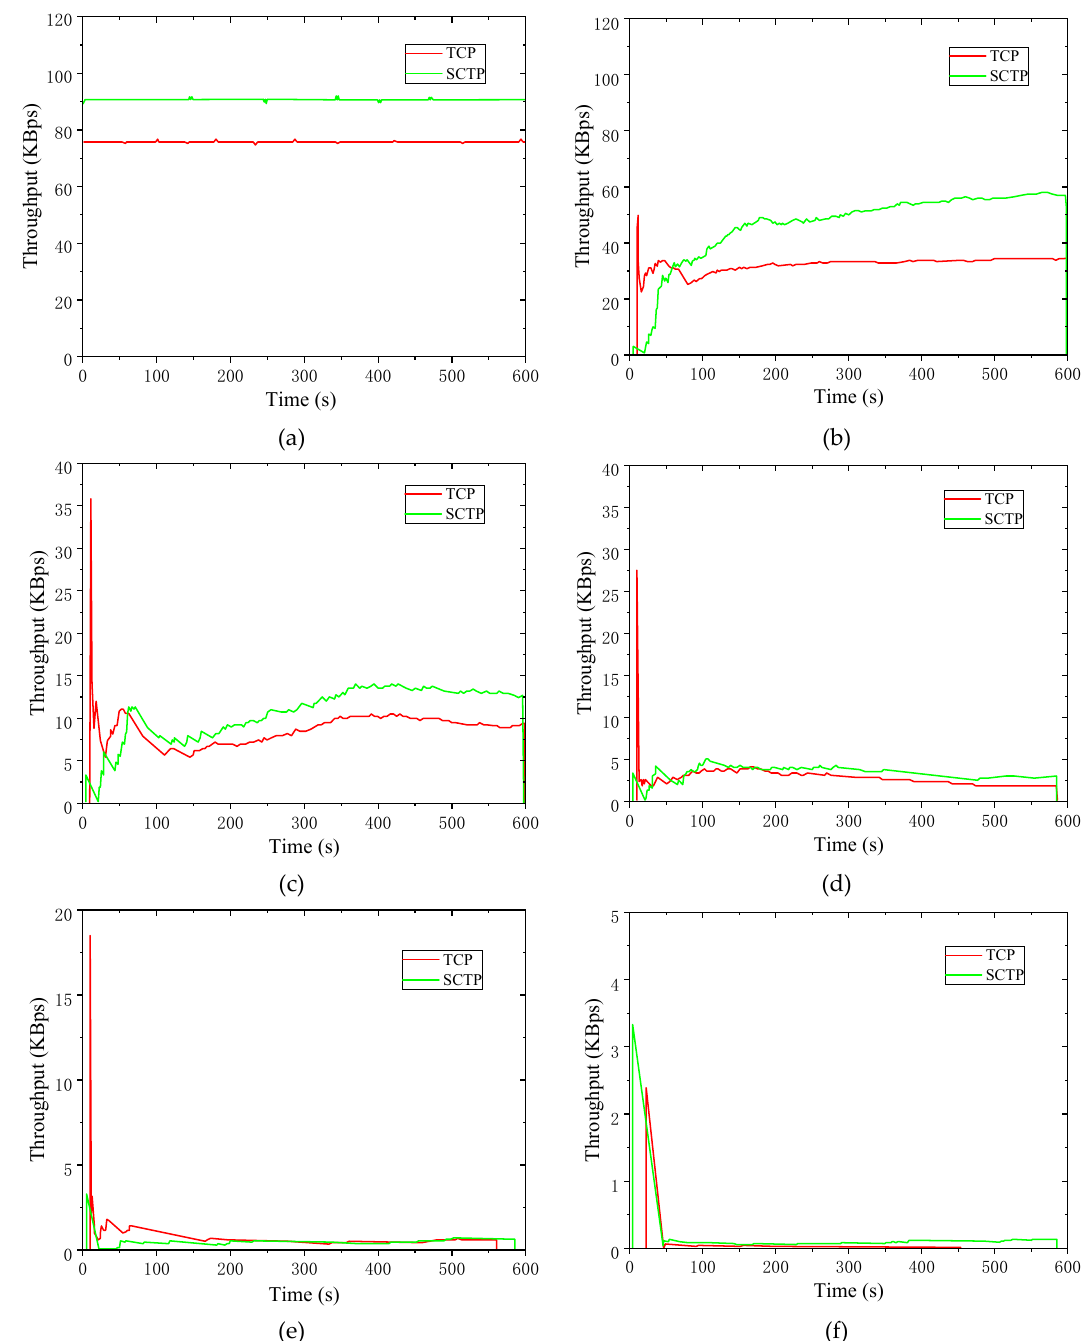
Figure 3. Real-time throughput comparison when the error rate is 0–50%. ( a ) Packet error rate (PER): 0%; ( b ) PER: 10%; ( c ) PER: 20%; ( d ) PER: 30%; ( e ) PER: 40%; ( f ) PER: 50%.